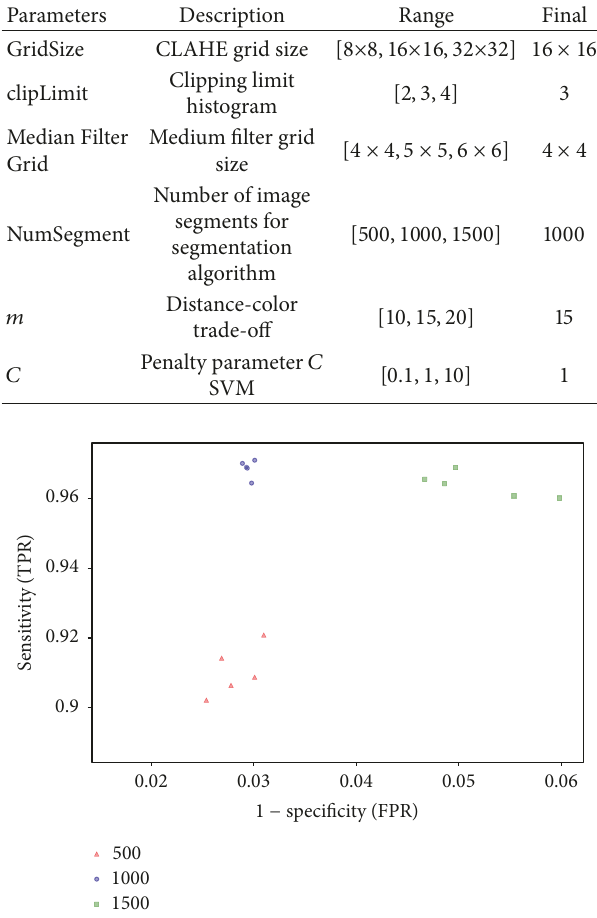
Figure 9: Sensitivity-specificity number segment